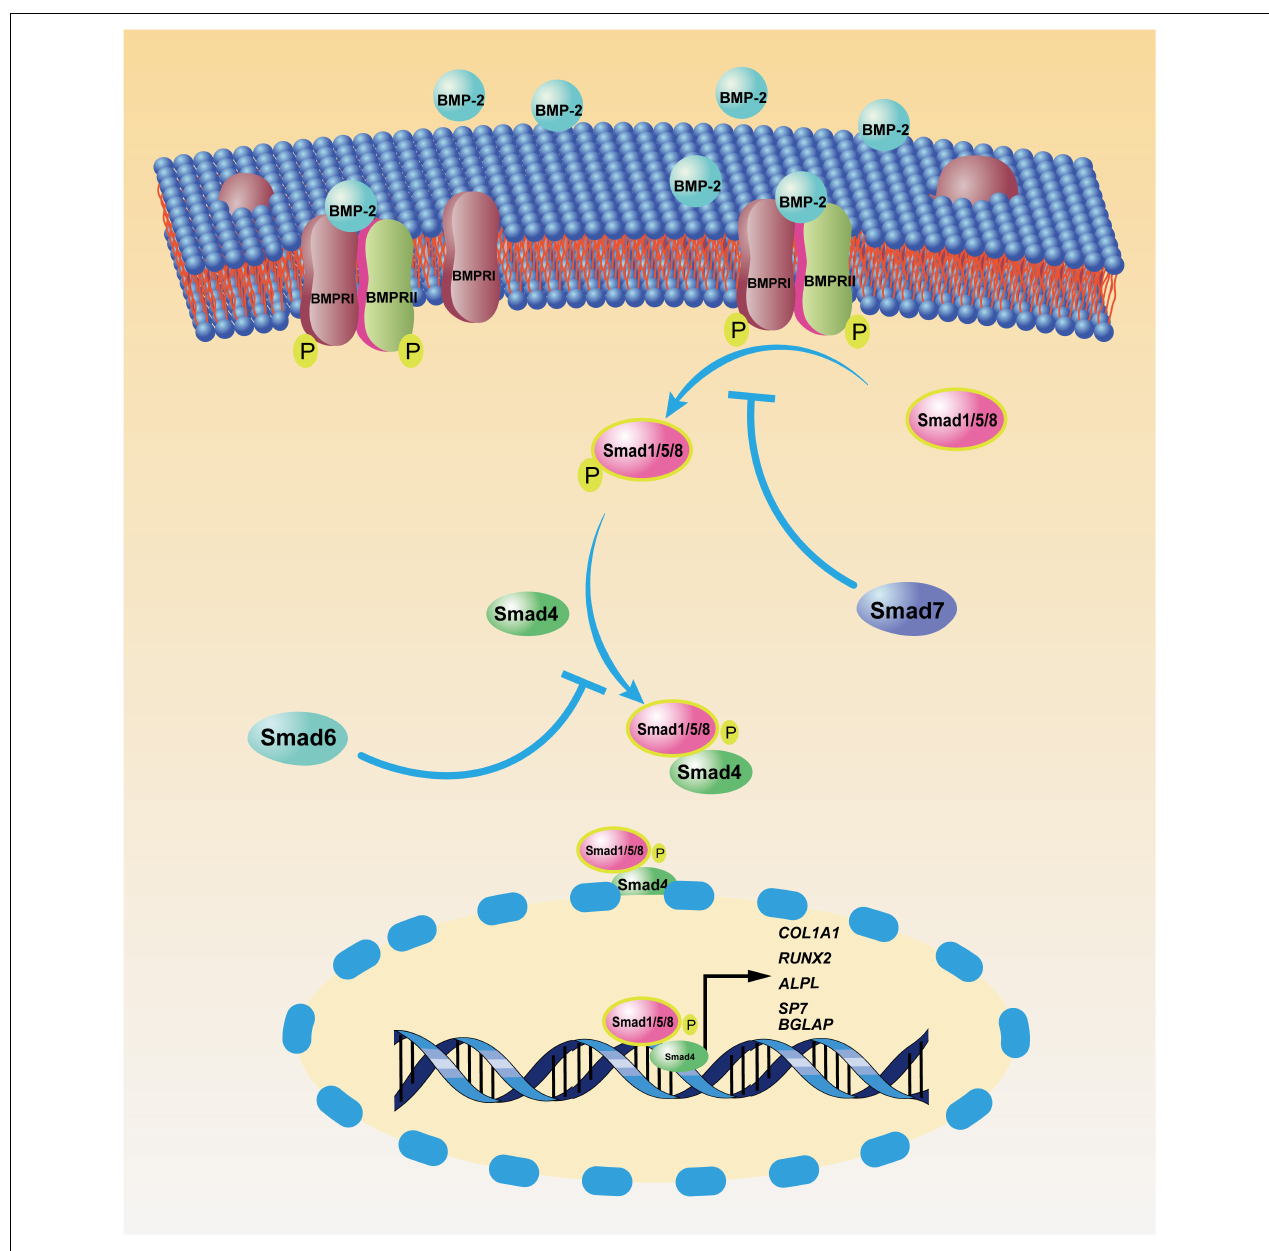
FIGURE 1 | Canonical bone morphogenic protein-2 (BMP-2) signaling pathway. After BMP-2 binds to its transmembrane receptors [bone morphogenic protein receptor (BMPR)I and BMPRII], these phosphorylated receptors facilitate the phosphorylation of mothers against decapentaplegic and the Caenorhabditis elegans protein 1/5/8 (Smad1/5/8) in the cytoplasm. Then, the complex of pSmad1/5/8 and Smad 4 translocates to the nucleus, where phosphorylated Smad1/5/8 (pSmad1/5/8) and Smad 4 function as transcription factors, enhancing the transcription of osteoblastic genes, including COL1A1, RUNX2, ALPL, SP7, and BGLAP . As negative feedback, Smad7 inhibits the phosphorylation of Smad1/5/8, and Smad6 prevents the nucleus translocation of the complex of pSmad1/5/8 and